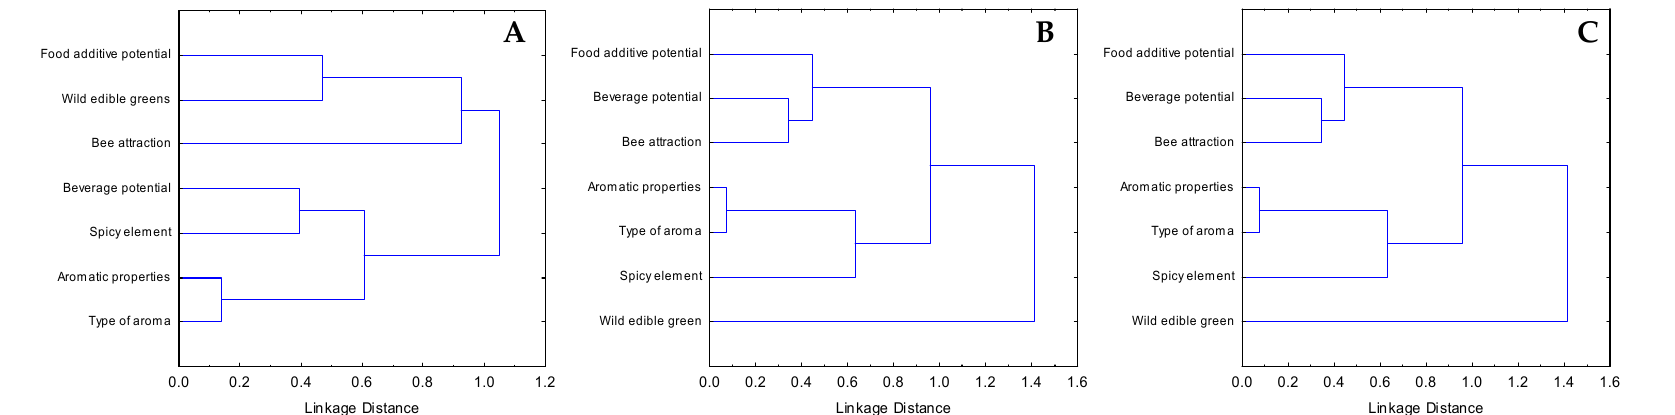
Figure 1. Graph of hierarchical clustering of the agro-alimentary attributes (complete linkage, 1-Pearson r distance) based on the score values of the local endemic plants of ( A ) Crete, ( B ) Mediterranean coast and Rif of Morocco, and ( C ) Tunisia.